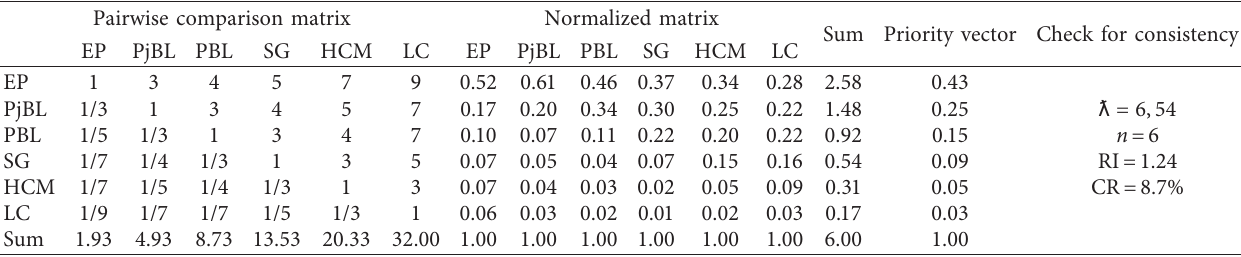
Table 10: Pairwise comparison matrix of learning strategies with respect to the Criterion “SS2. Organization, rigour, and efficiency.” Pairwise comparison matrix Normalized matrix